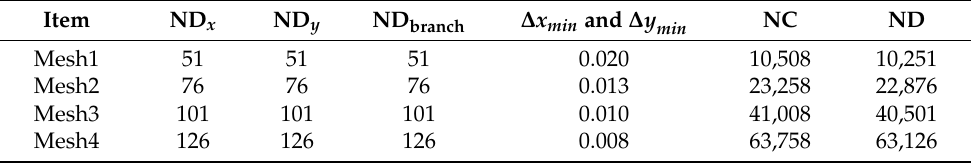
Table 4. Characteristics of the meshes used in the grid independence